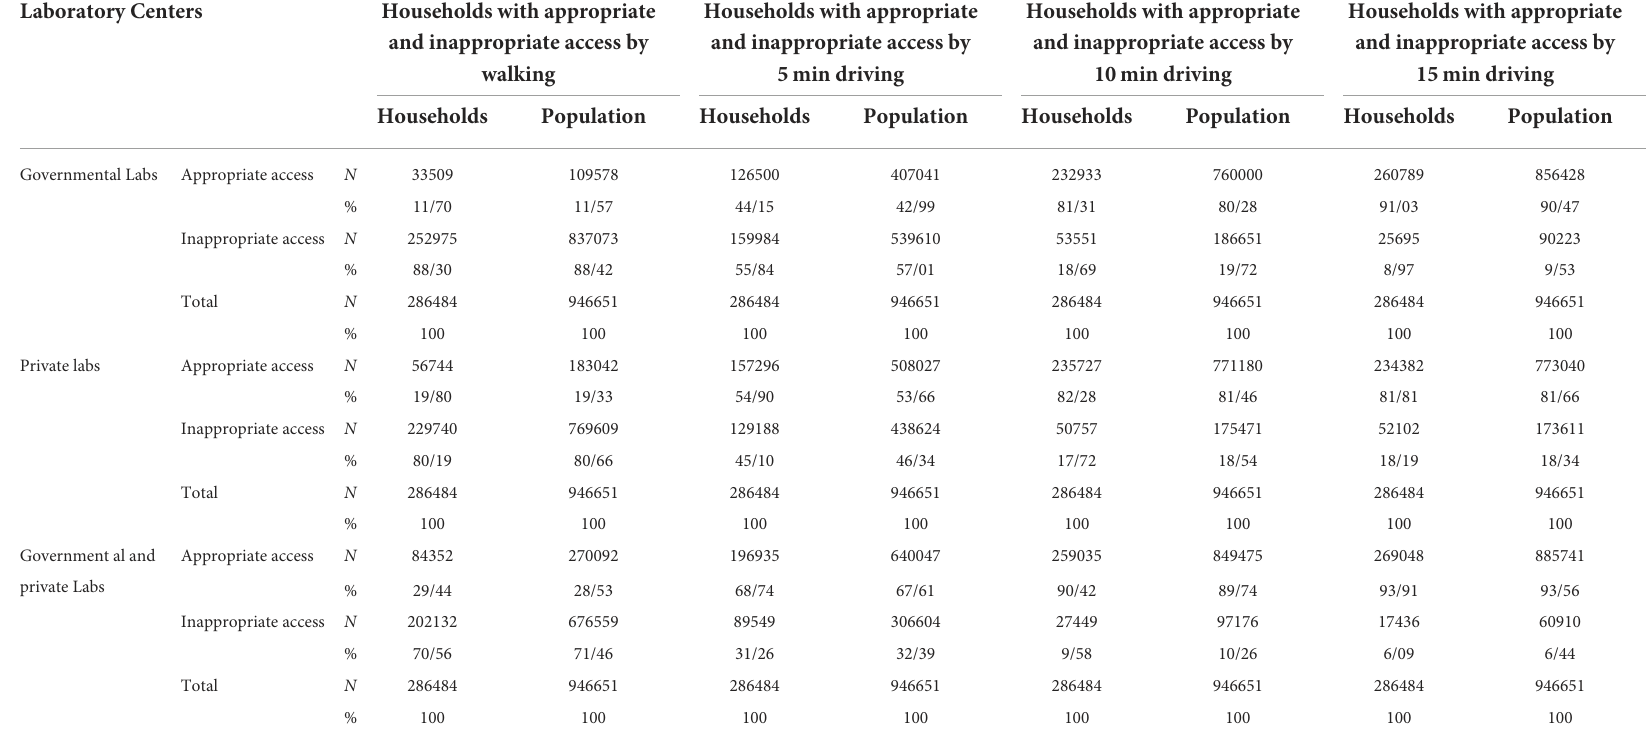
TABLE 1 Comparison of appropriate and inappropriate access to Governmental and private Labs in